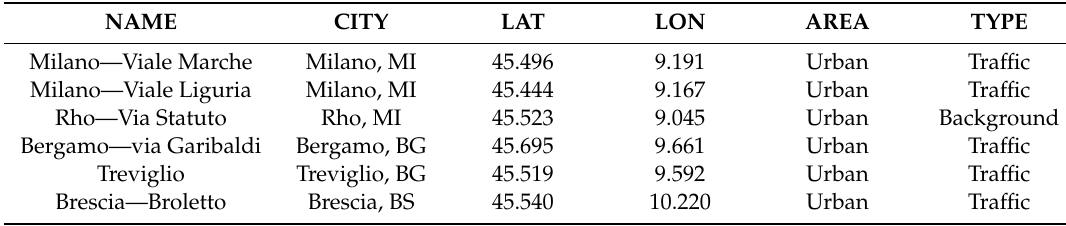
Table 3. Main characteristics of air quality monitoring stations (ARPA